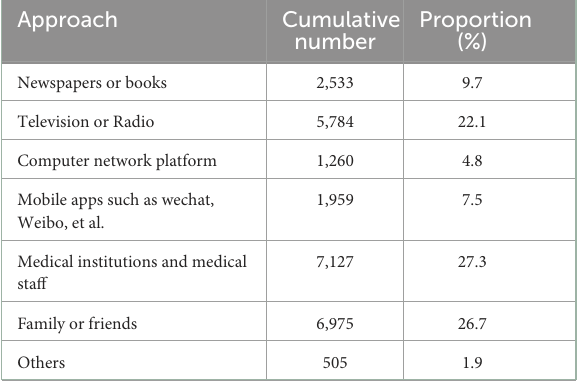
TABLE 5 Reasons why the elderly aged 70 years and above in Hangzhou are not willing to receive free influenza vaccines.